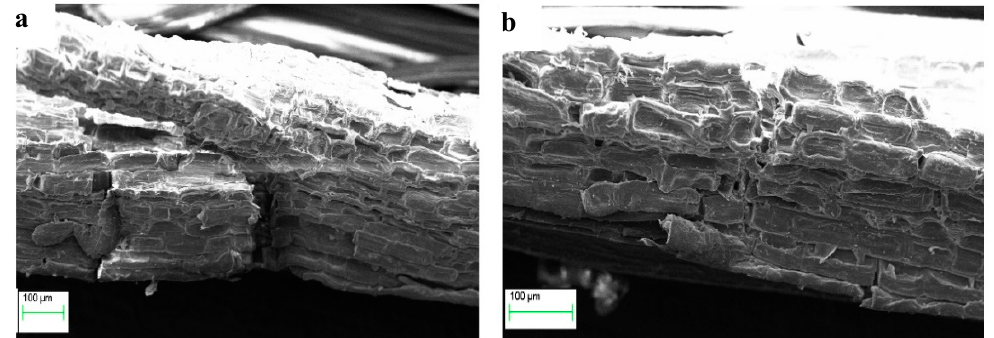
Figure 6. Microstructure of the surface of the single-cellulosic Buluh semantan strips soaked for 18 h in 4 wt.% NaOH showing in ( a ), and ( b ) large number of regularly spaced holes or pits in di ff erent